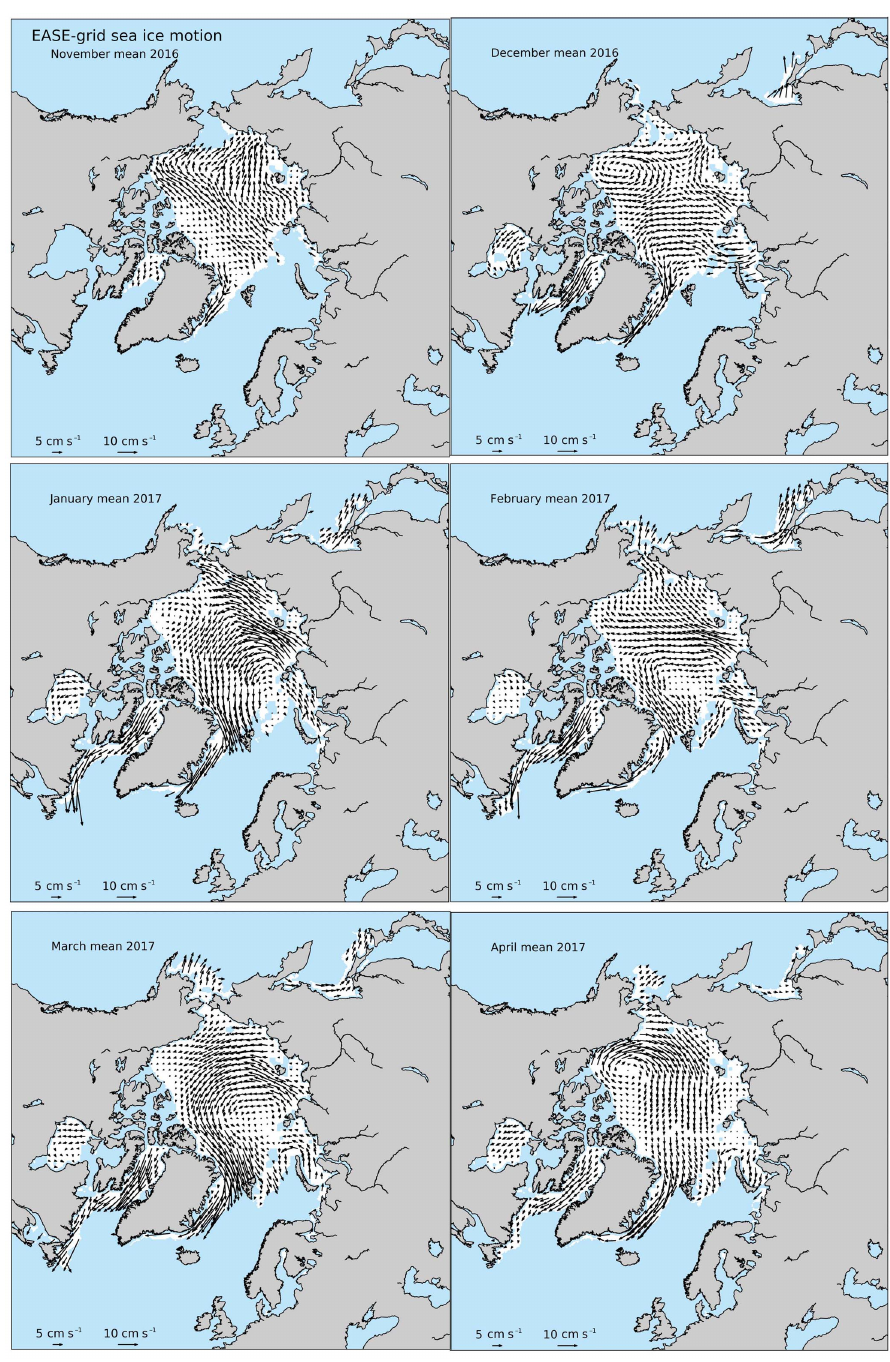
Figure 8. Mean monthly sea ice motion from the NSIDC Polar Pathfinder Data Set. Preliminary data provided by Scott Stewart,